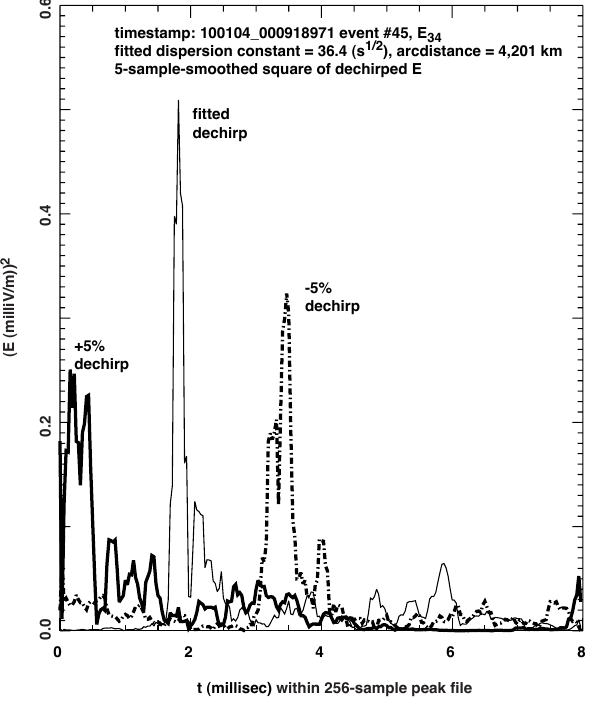
ing peak #45 from the burst recording of Fig. 1. The light solid curve is the smoothed square of the dechirped electric field, using the optimal dechirp (36.4s 1 / 2 ). Each heavy curve is for dechirp- ing with a different dispersion constant, perturbed from optimal by + 5% (solid) and − 5%